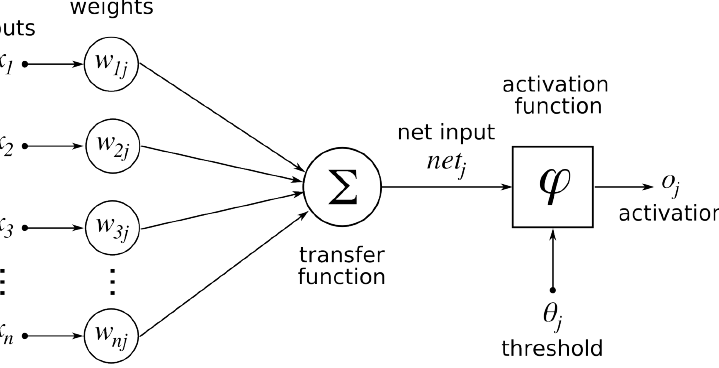
Figure 2. Computational schema of a neuron in a neural network. The input values are aggre- gated (usually by a weighted sum) and then a non-linear activation function is applied. Figure ob- tained at https://commons.wikimedia.org/wiki/File:ArtificialNeuronModel_english.png, accessed on 20 April